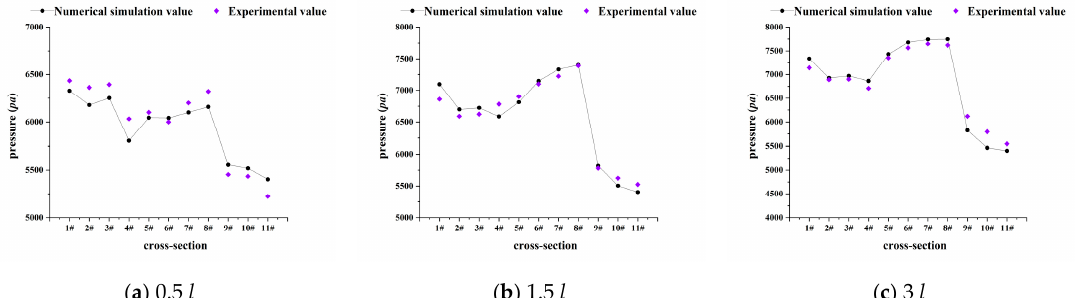
Figure 18. Comparison of experimental values and numerical simulation values of the average pressure. ( a – c ) The comparison between the numerical simulation values and the experimental values with vehicle spacings of 0.5 l / 1.5 l / 3 l .